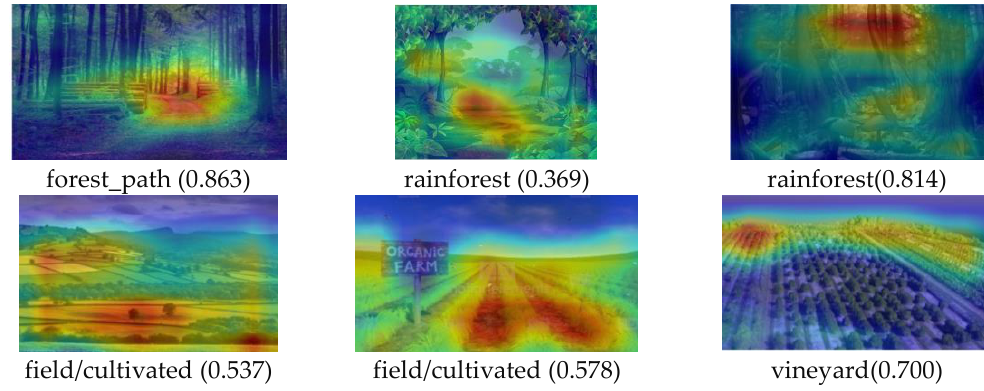
Figure 4. The top-1 classified categories of the test images by using the Places365 demo.